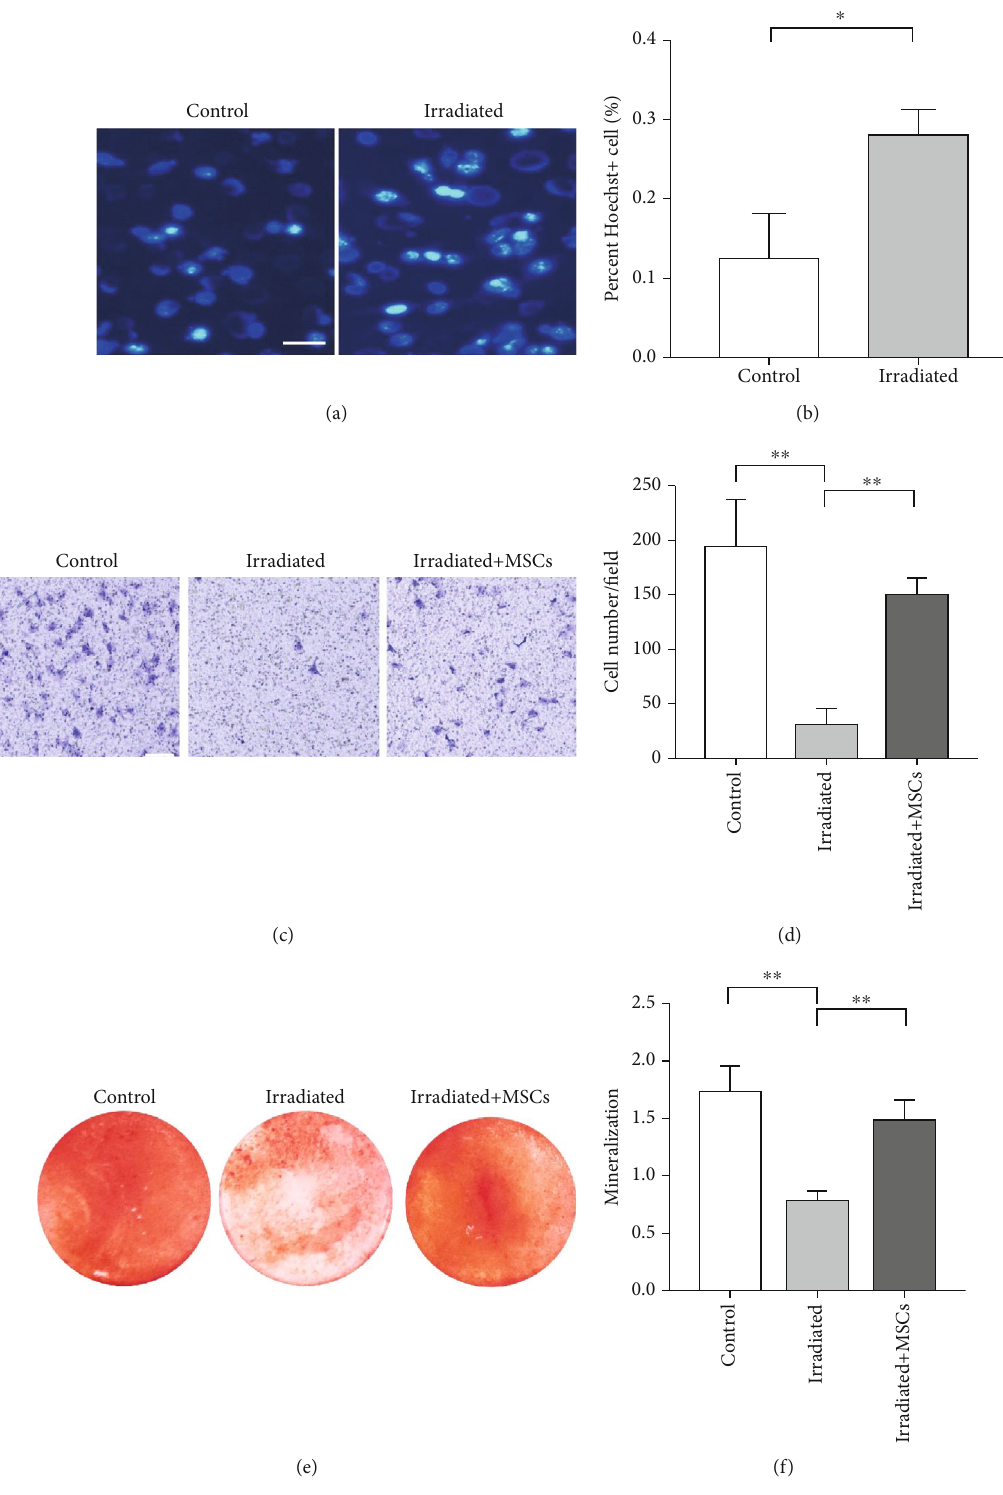
Figure 2: hUCB-MSCs can rescue the function of irradiated osteogenic precursor cells. (a) Hoechst staining in MSC treatment and irradiated MC3T3 (scale bar, 100 μ m). (b) Statistics of Hoechst in MSC treatment and irradiated MC3T3s. (c) Transwell in control, MSC treatment, and irradiated MC3T3 (scale bar, 100 μ m). (d) Statistics of transwell in control, MSC treatment, and irradiated MC3T3. (e) Alizarin red staining in control, irradiated, and irradiated with MSC treatment MC3T3. (f) Statistics of Alizarin red staining in control, irradiated, and irradiated with MSC treatment MC3T3. All data are the mean ± SD ; ∗ P < 0 : 05 ; ∗∗ P < 0 : 01